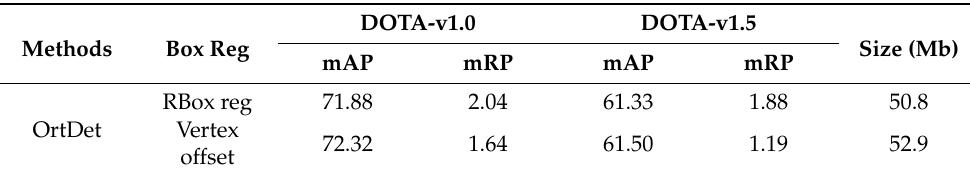
Table 7. Performance comparisons of the box regression on